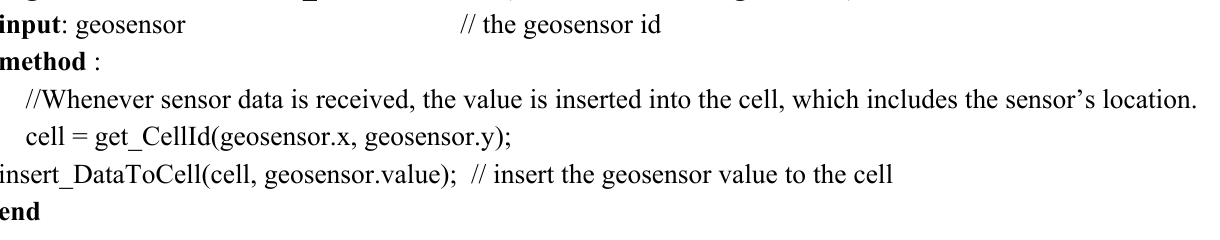
Algorithm 1. Insert geosensor data to